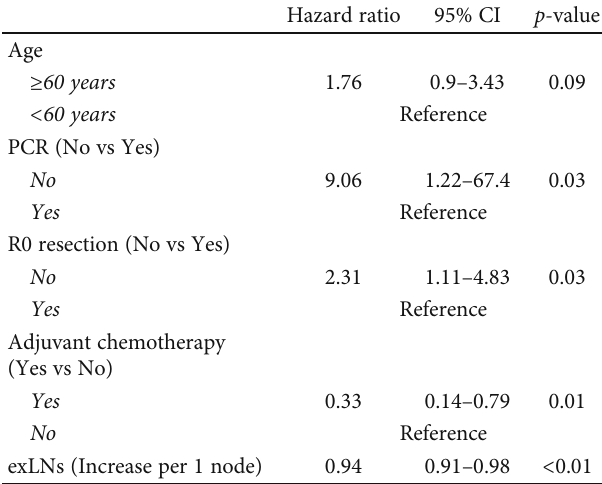
Table 4: Hazard ratio, 95% con fi dence interval, and p value of each predictor in the Cox regression model ( n = 215